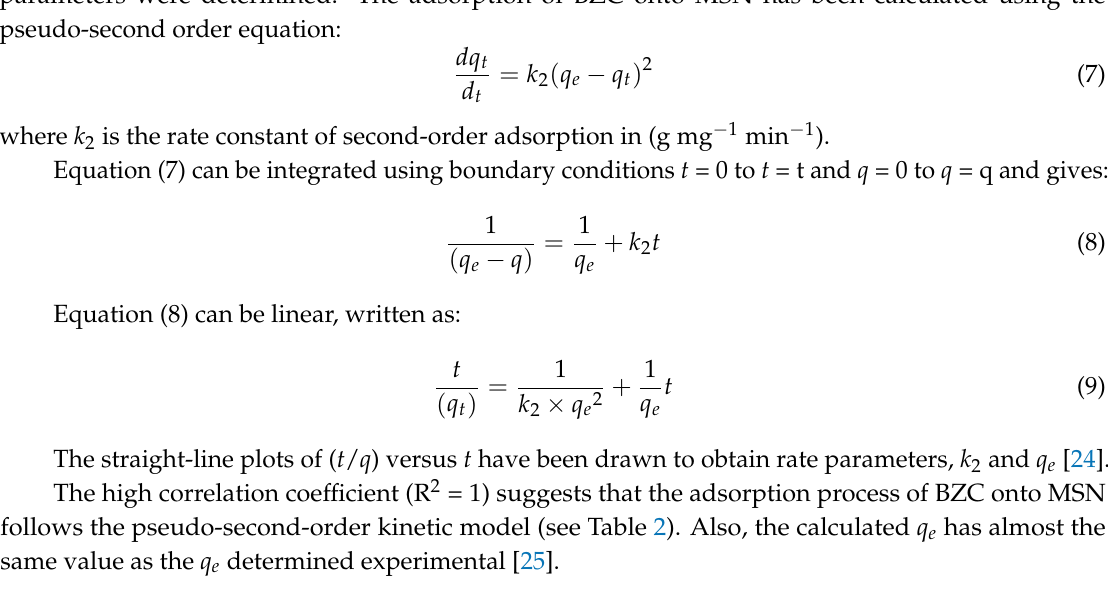
Table 2. Kinetic parameters for BZC adsorption onto MSN.